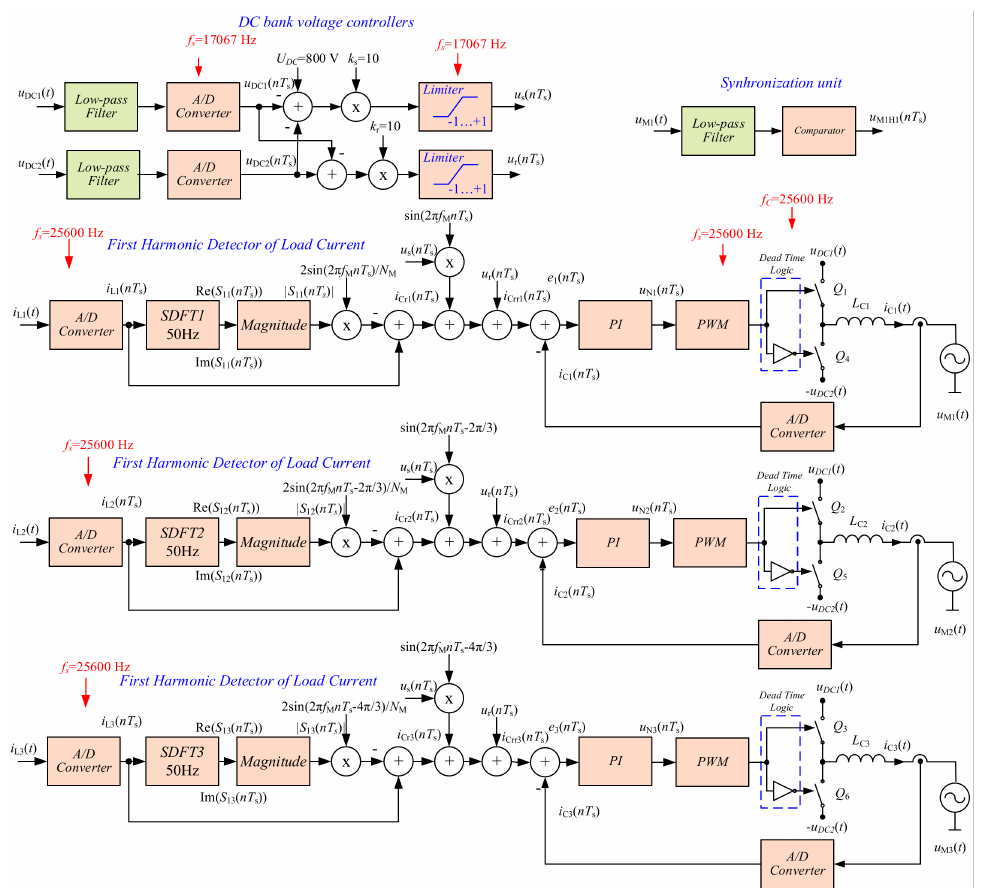
Figure 3. Simplified block diagram of APF control